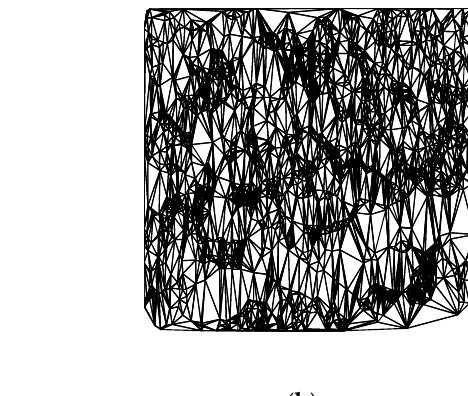
same area. the same area.